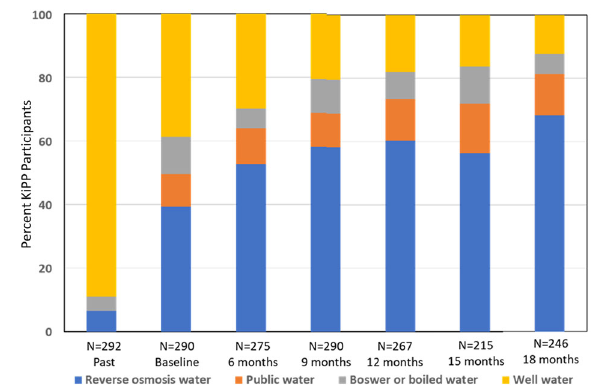
Fig. 1 Percent of KiPP participants reporting speci fi c drinking water source prior to the study (past) and at each time point. Note the number of participants at each time point is speci fi ed as not all participants were available at each follow